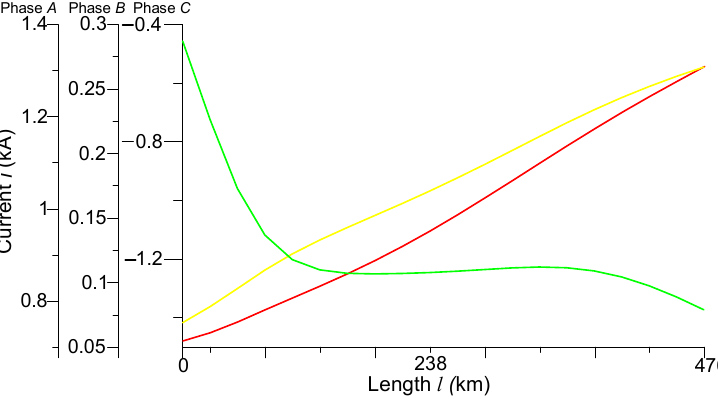
Figure 3. Spatial distributions of phase currents in the line at time t = 0.007 s.